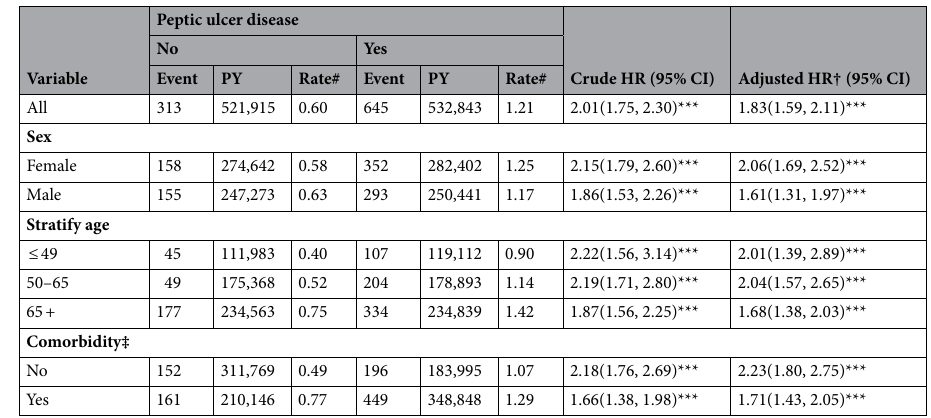
Table 2. Comparison of incidence and hazard ratio of chronic fatigue syndrome stratified by sex, age and comorbidity between patients with and without peptic ulcer disease. Rate#, incidence rate, per 1,000 person-years; Crude HR, crude hazard ratio. Adjusted HR†: multivariable analysis including age, sex, and comorbidities of diabetes, obesity, renal disease, rhematoid arthritis, HIV, and malignancy, untreated hypothyroidism, sleep apnea, narcolepsy, HBV, HCV, depression, anxiety, bipolar affective disorders, schizophrenia, delusional disorders, dementia, anorexia or bulimia nervosa, and alcohol or other substance abuse. Comorbidity‡: Patients with any one of the comorbidities diabetes, obesity, renal disease, rhematoid arthritis, HIV, malignancy, untreated hypothyroidism, sleep apnea, narcolepsy, HBV, HCV, depression, anxiety, bipolar affective disorders, schizophrenia, delusional disorders, dementia, anorexia or bulimia nervosa, and alcohol or other substance abuse were classified as the comorbidity group. *p < 0.05, **p < 0.01, ***p < 0.001.